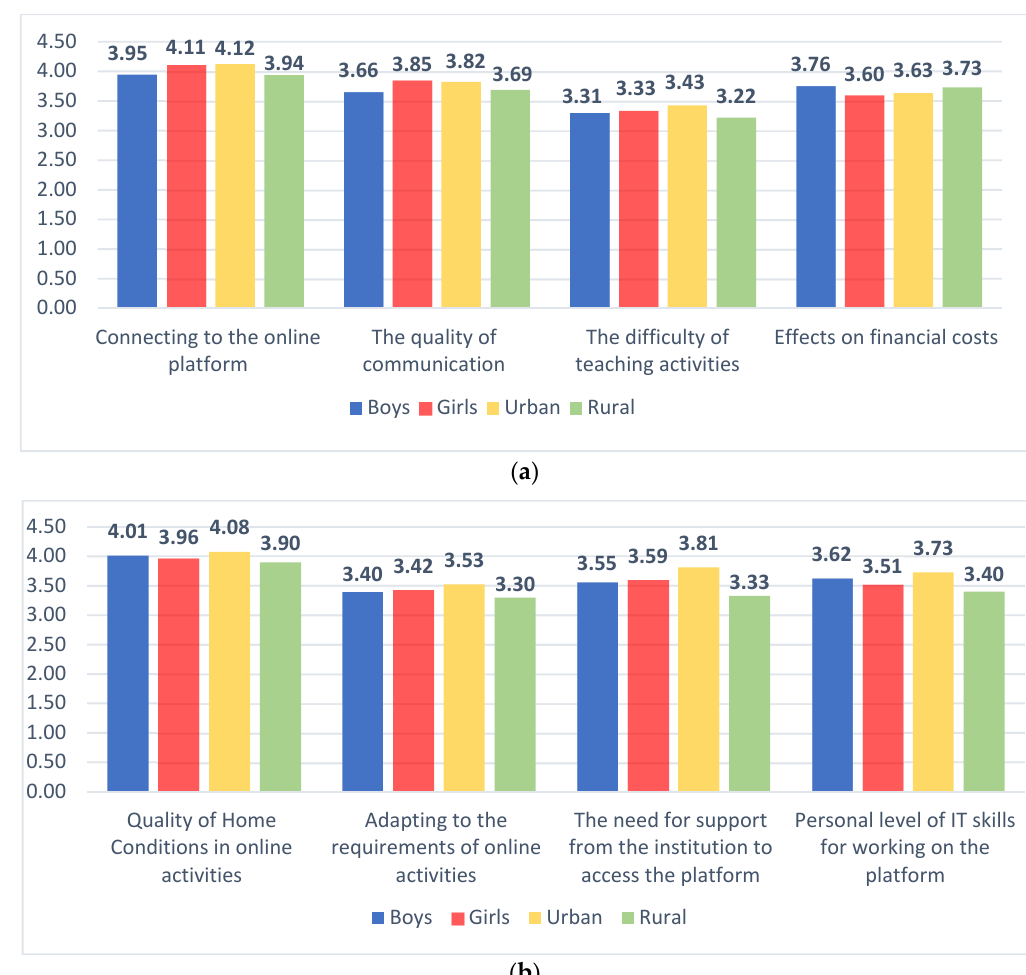
Figure 2. ( a ) The average values of the answers for the items of the accessibility factor. ( b ) The average values of the answers for the items of the accessibility factor. Table 7. Tests of between-subjects’ effects—the cumulative effect of gender variables * area variables on F3 factor items/motivation.